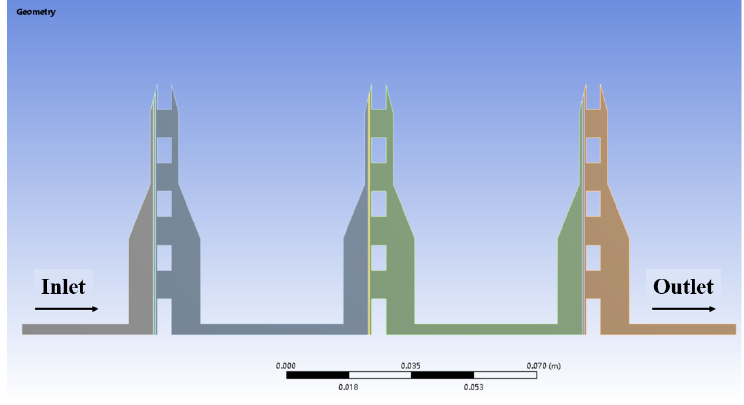
Figure 5. Multi-stage membrane filtration model